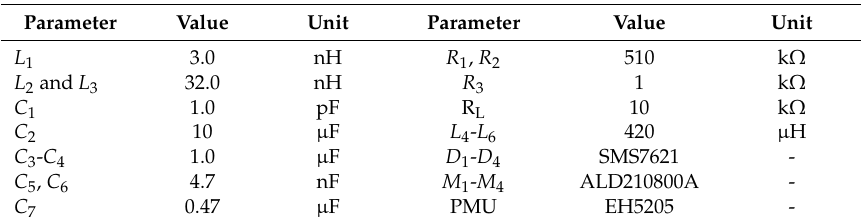
Table 3. The proposed circuit components value.